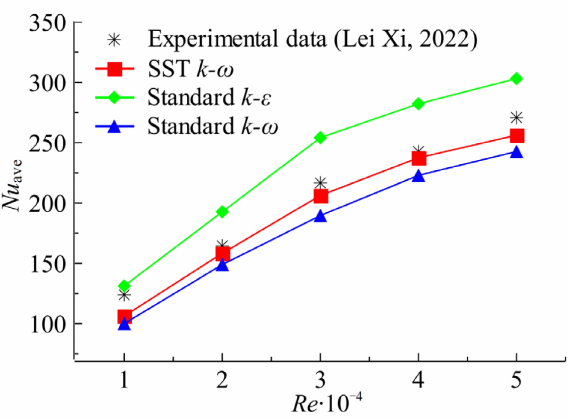
Figure 3. Verification of numerical methods based on the experimental data in